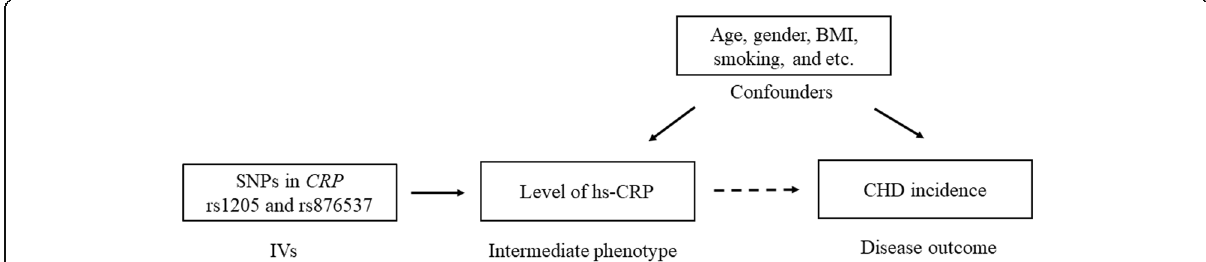
Fig. 1 The basic principle of Mendelian Randomization analysis for the current study. BMI, body mass index; CRP, C-reactive protein; CHD, coronary heart disease; IVs, instrumental variables; SNP, single nucleotide